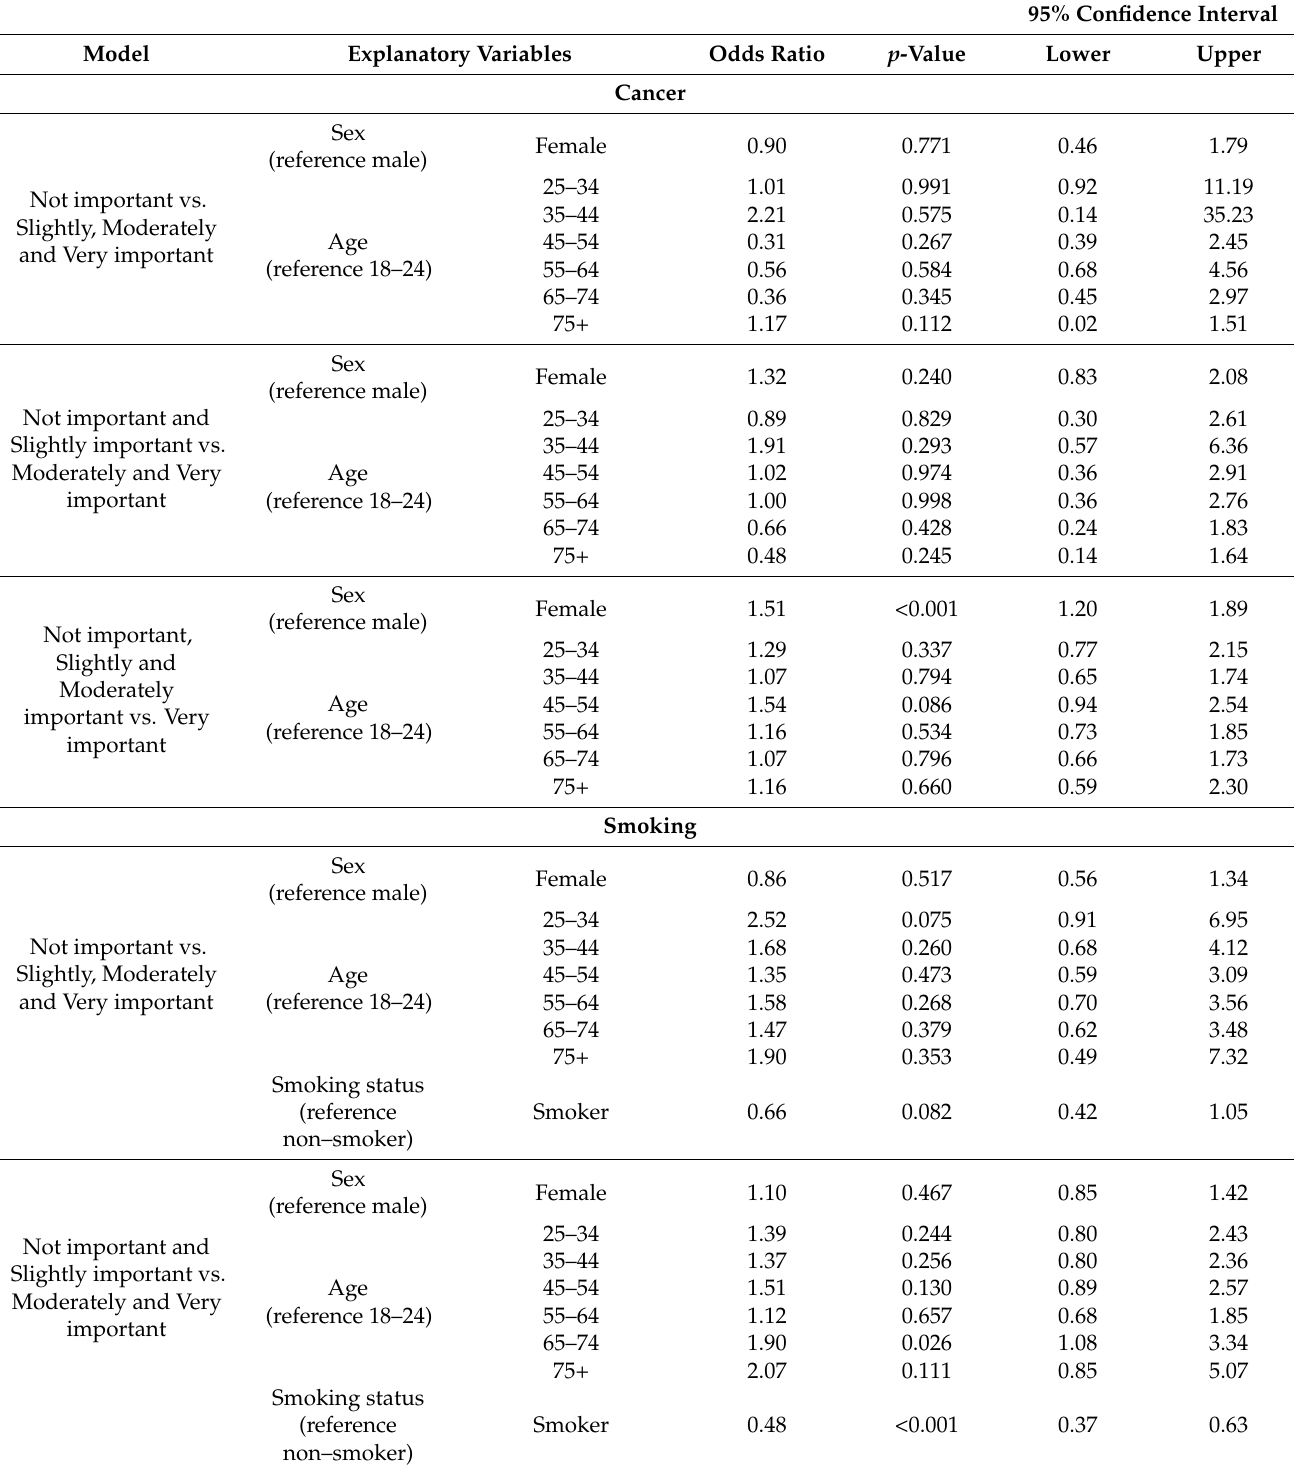
Table A2. Generalized ordered logistic regressions for perceived importance of public health